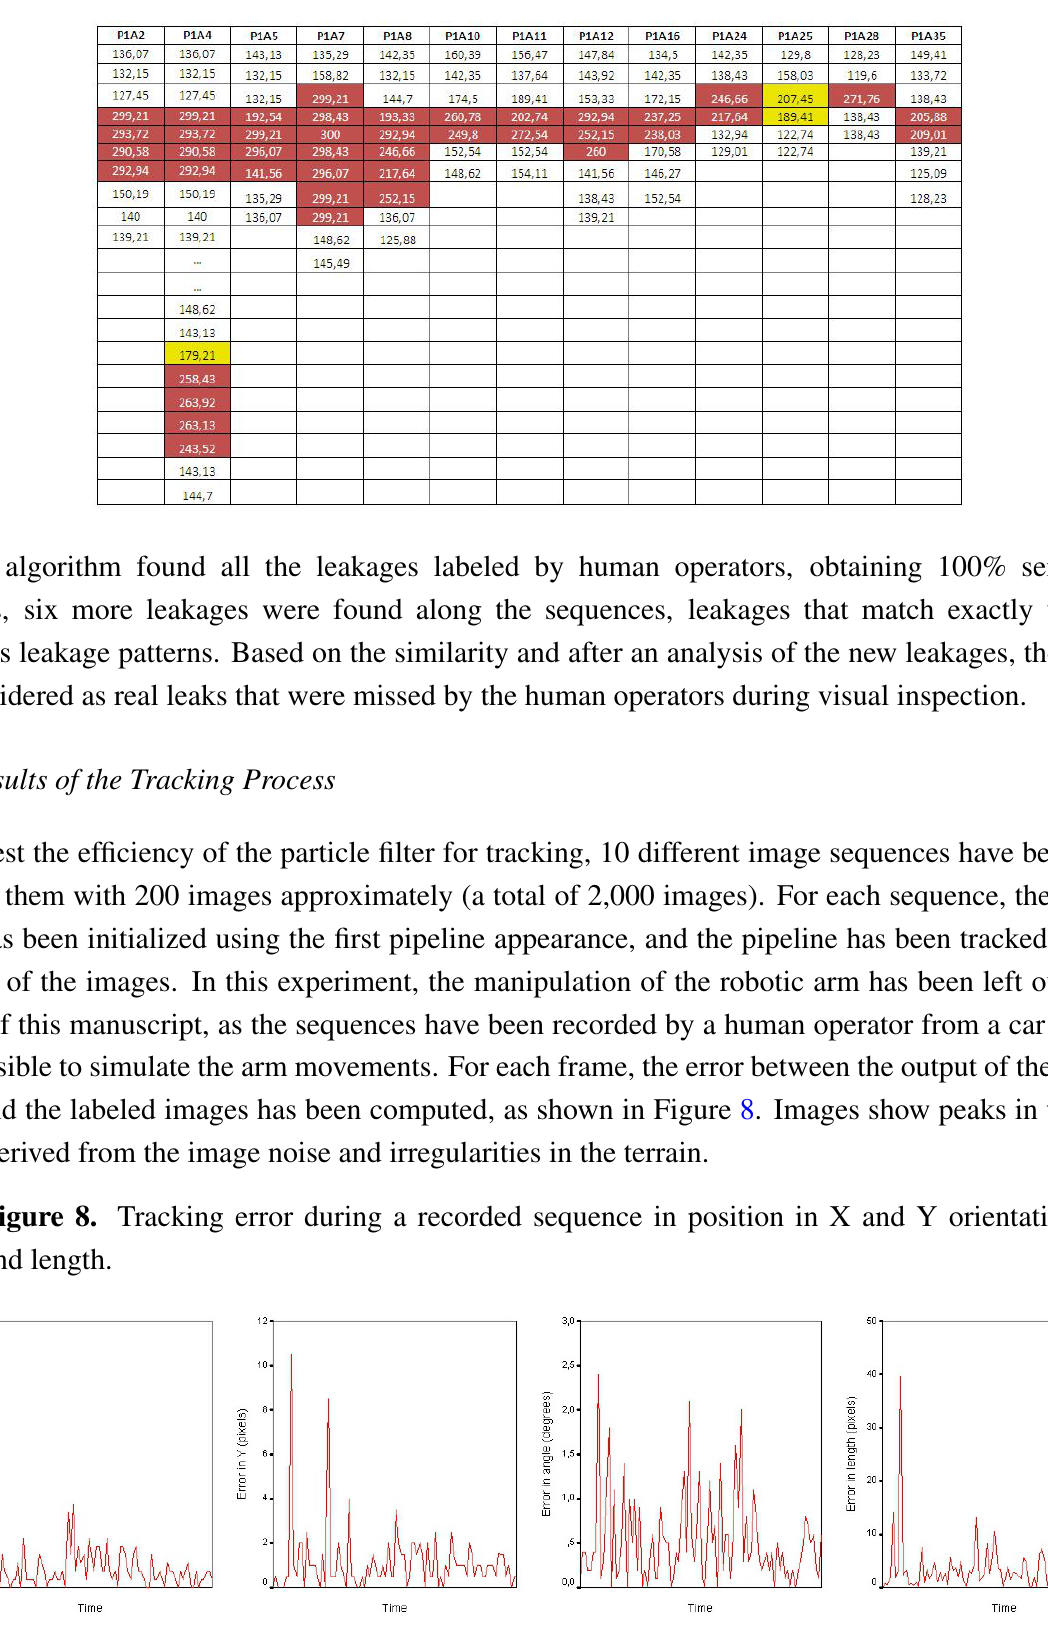
Figure 7. Example of changes in temperature in recorded image sequences.